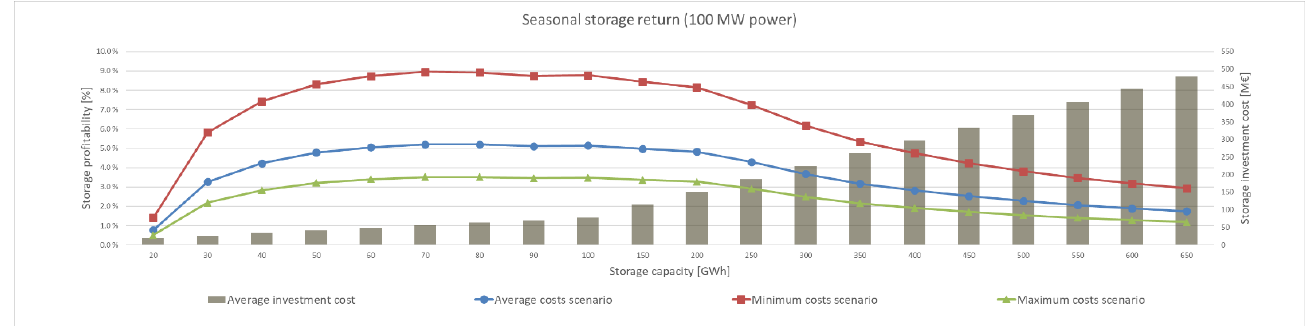
Figure A1. The 100 MW seasonal storage return.